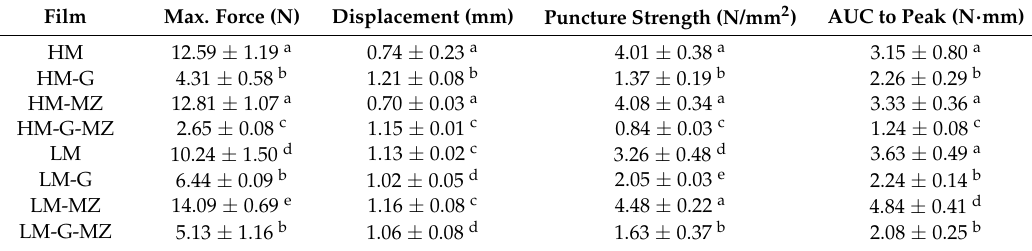
Table 3. Mechanical properties of the